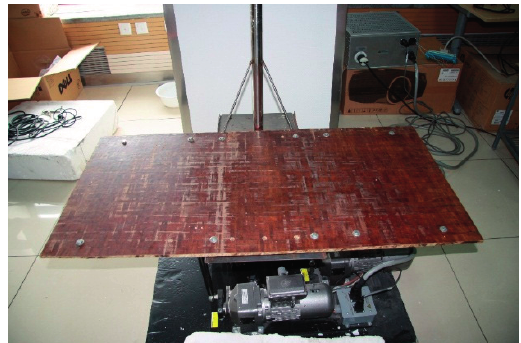
Figure 2. The standing platform setup.